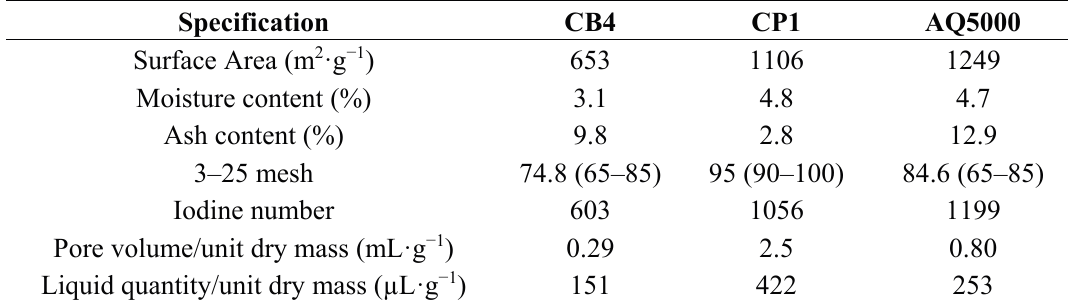
Table 1. Characteristics of the different activated carbon (AC)